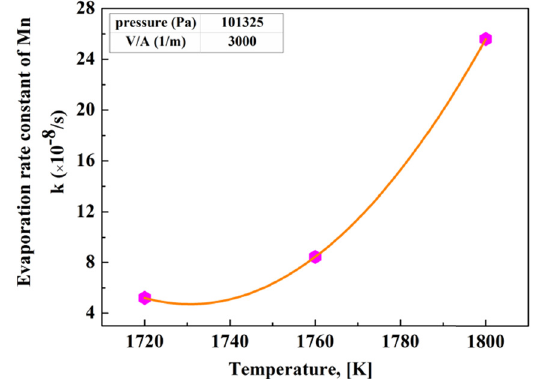
Figure 2: The relationship between ([ ] [ ] ) / ln Mn Mn t 0 and ( ) / ⋅ S V t in high manganese steel melt.